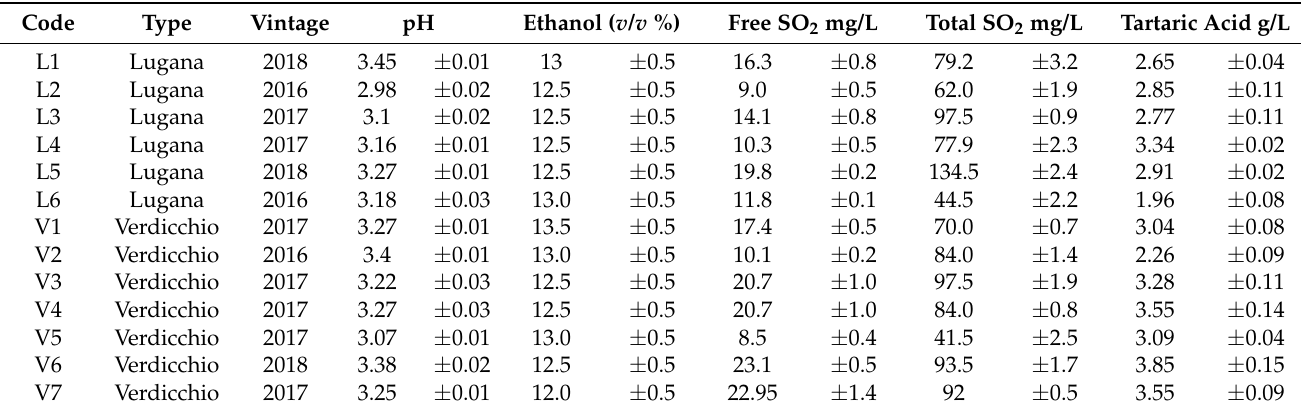
Table 6. Wine samples and base enological